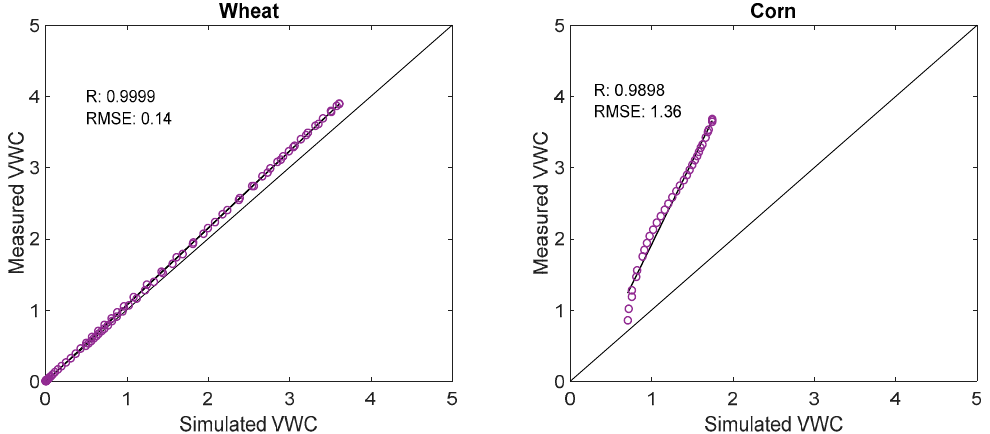
Figure 8. Simulated vegetation water content (VWC) compared to measured VWC (left: wheat, right: corn).